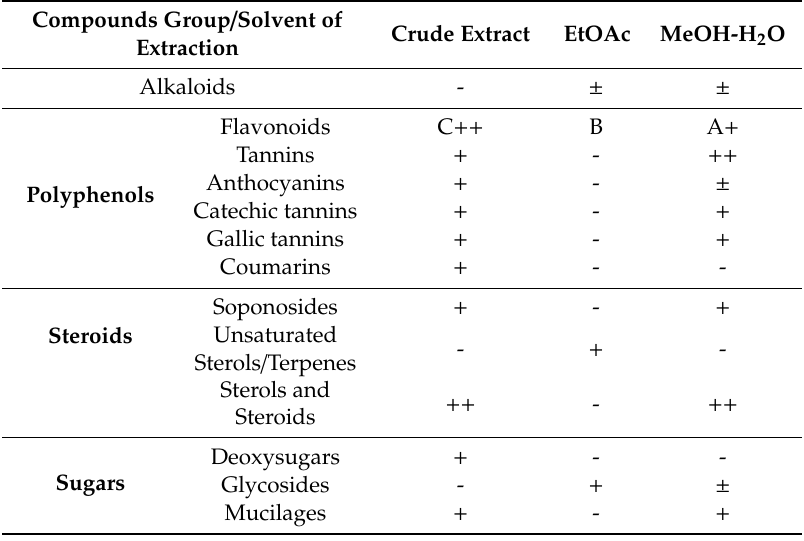
Table 2. Phytochemicals detected in Z. lotus extracts. Compounds Group / Solvent of Extraction